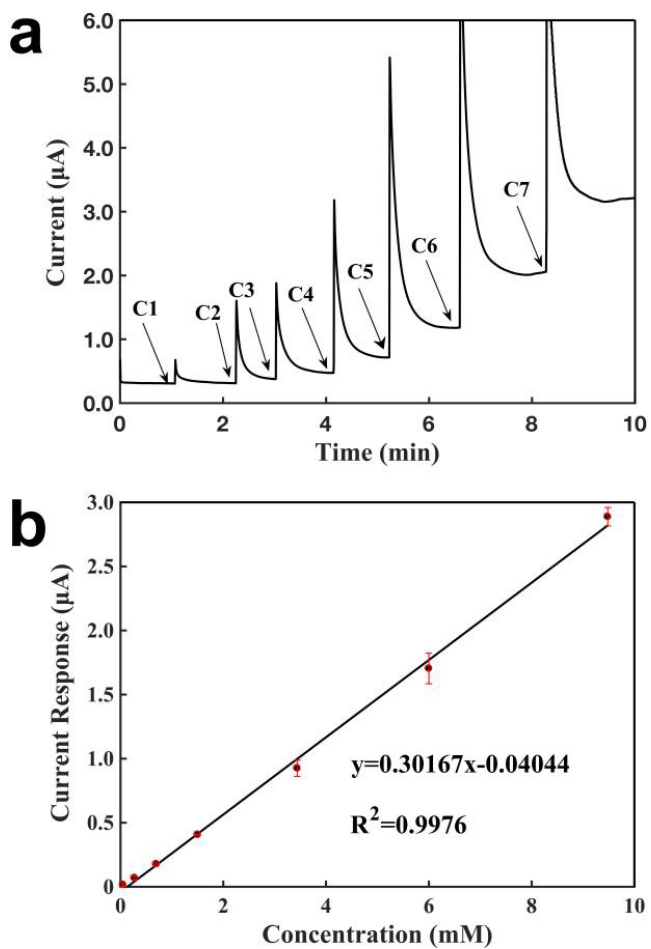
Figure 7. Characterization of a glove sensor based on two CNT electrodes and an Ag/AgCl electrode for the detection of H 2 O 2 . Operating potential: 0.6 V of working electrode vs reference electrode (Ag/AgCl 50:50). ( a ) Current-verses-time response curve upon the additions of H 2 O 2 . C1: 0.048 mM, C2: 0.089 mM, C3: 0.30 mM, C4: 0.40 mM, C5: 0.77 mM, C6: 1.86 mM, C7: 2.47 mM. ( b ) Calibration curve for the detection of H 2 O 2 . Each error bar was from three measurements.